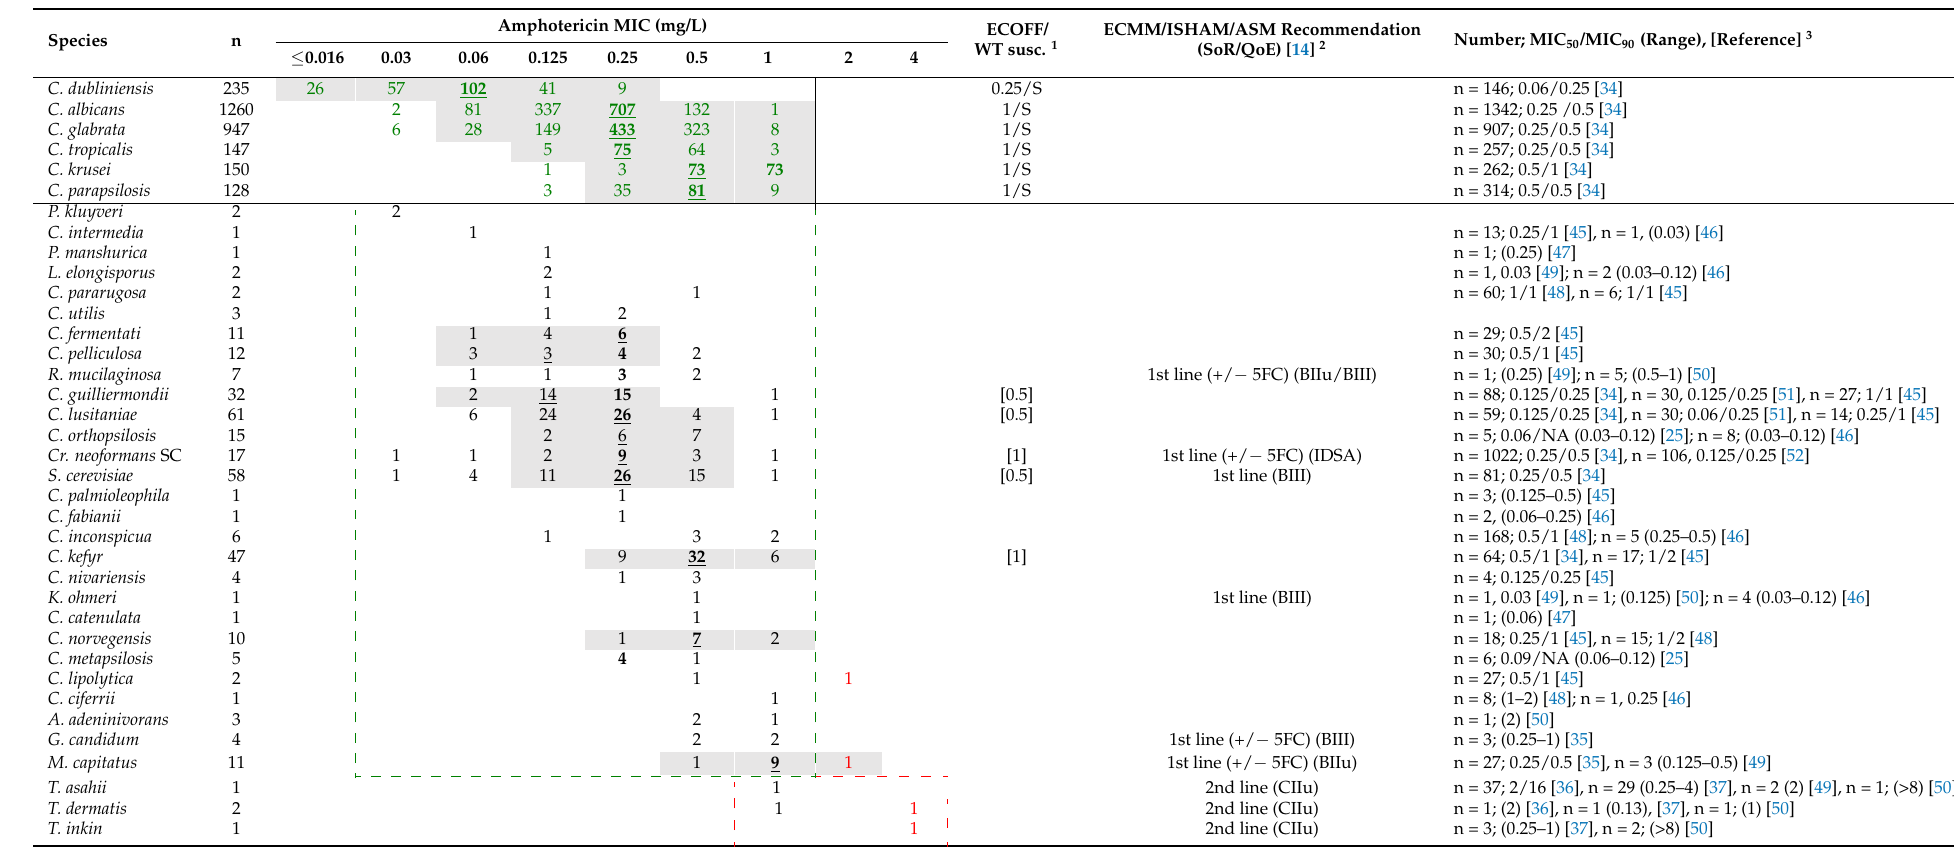
Table 4. Amphotericin B EUCAST MICs against Danish common and rare yeast species sorted by increasing MICs. The coloured boxes indicate the intrinsic